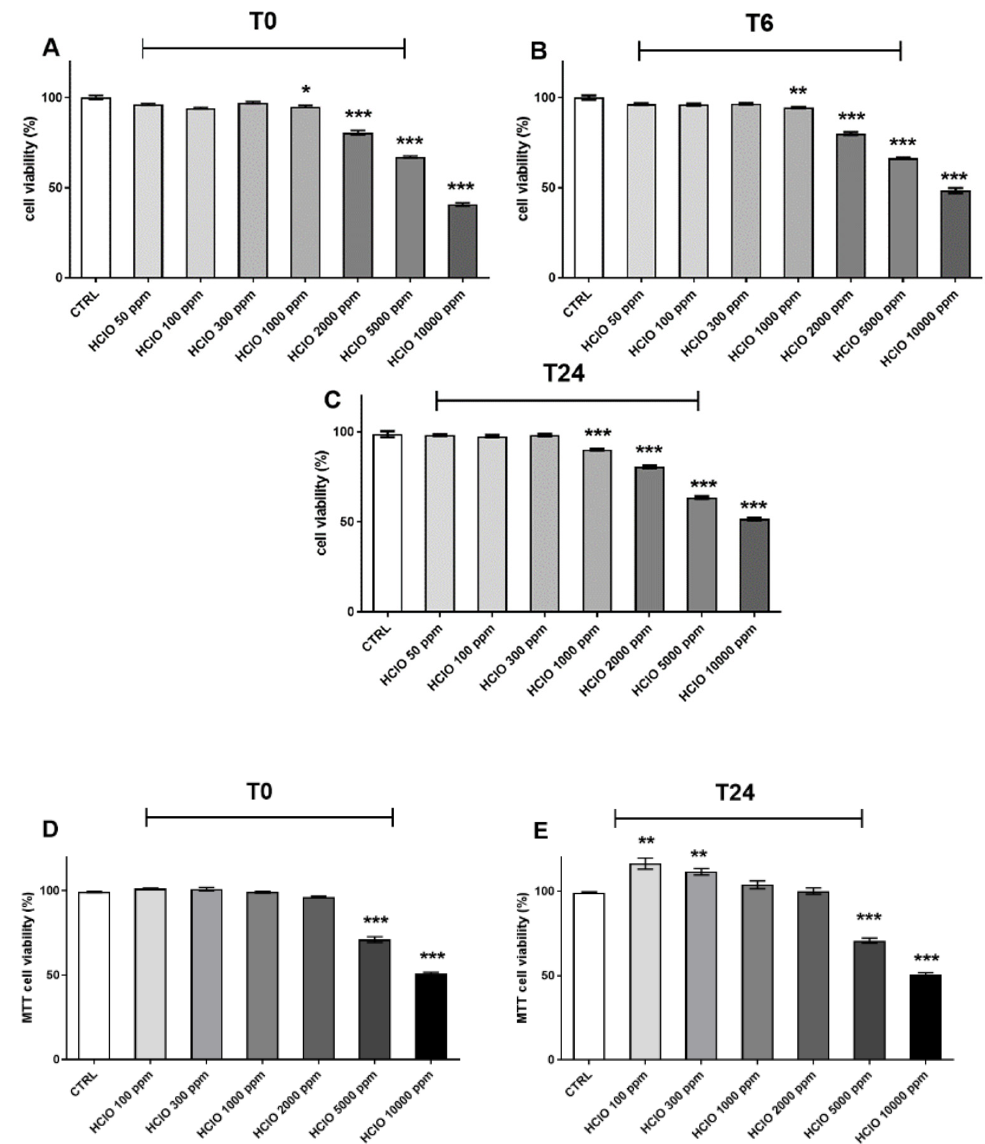
Figure 1. Effects of HOCl nebulization on HaCaT cell proliferation and viability; after the nebulization of different doses of HOCl, cells were collected immediately after the exposure and after 6 or 24 h. Cell viability was assessed by Trypan blue exclusion test ( upper panels , A – C ) and MTT assay ( below panels , D , E ). Data are expressed as mean ± SEM of four different experiments. * p < 0.05; ** p < 0.01; *** p < 0.0001 exposed vs. CTRL. Results were analyzed by One-way ANOVA.